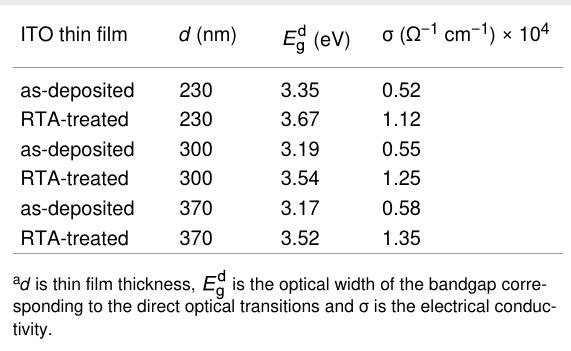
Table 4: The values of the bandgap width corresponding to direct optical transitions and the electrical conductivity for the as-deposited and RTA-treated ITO samples.